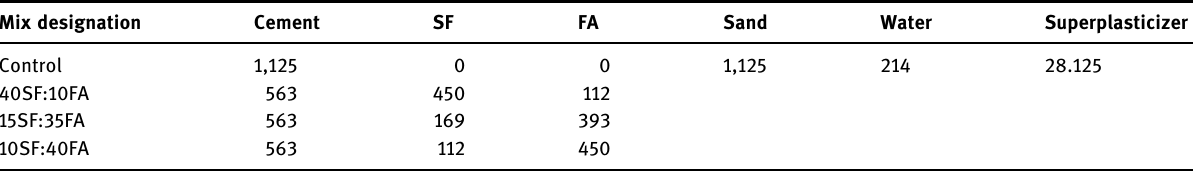
Table 3: Mix proportion details of the RPC ( kg/m 3 )